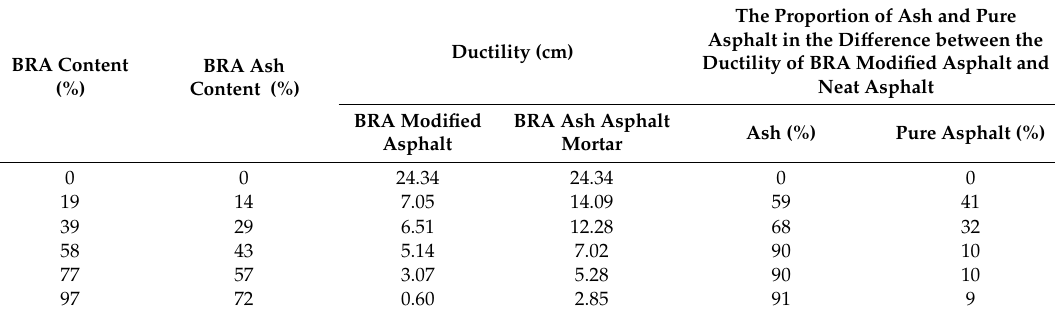
Table 13. Percentage of ductility of di ff erent components in BRA.